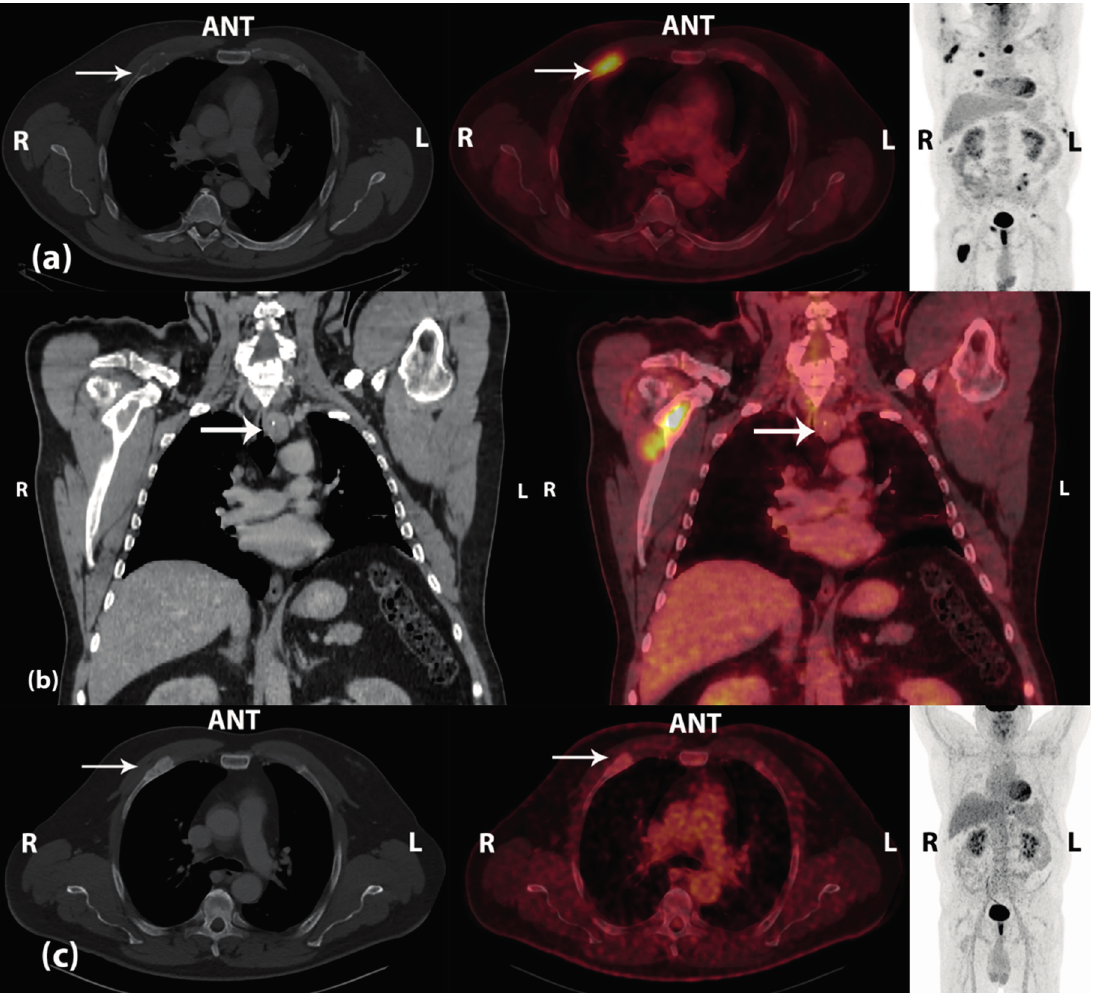
Figure 1. ( a ) Initial scan—left and middle: CT (bone window) and fused 18 F-FDG